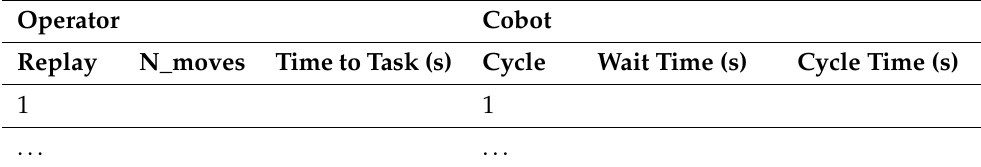
Table A2. Scenario. Task 1 & Task 2: Resolve TOH5 & Collaborate with cobot (CA).